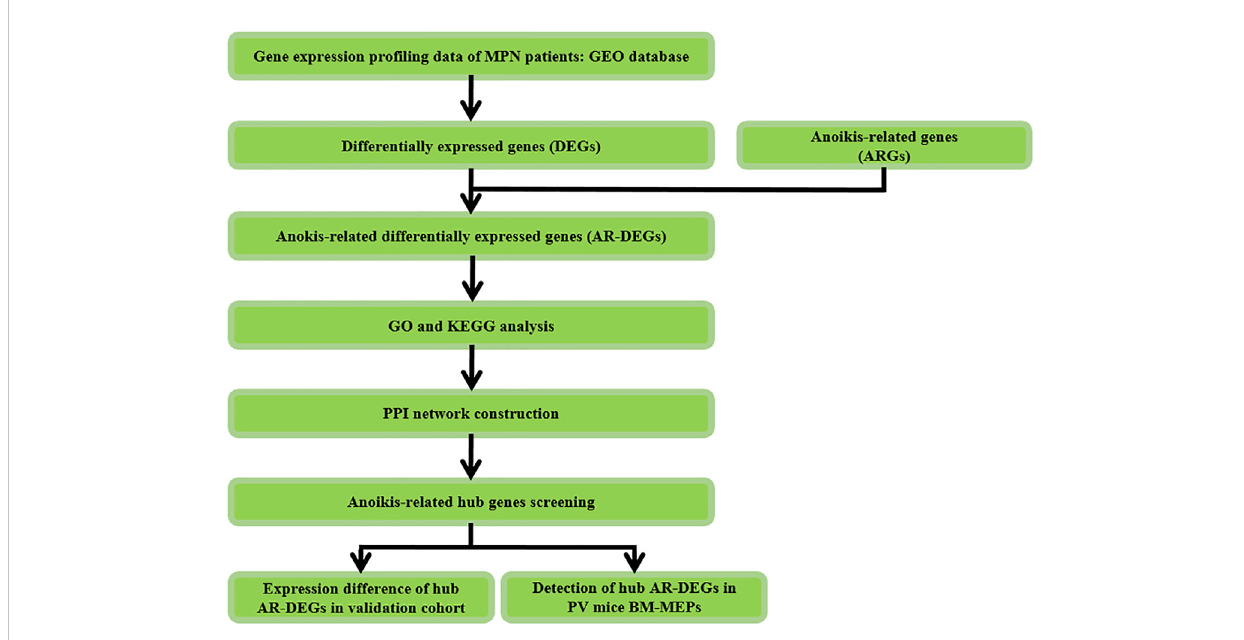
FIGURE 1 Study fl owchart. GSE, Gene Expression Omnibus Series; GO, gene ontology; KEGG, Kyoto Encyclopedia of Genes and Genomes; PV, Polycythemia Vera; BM, Bone Marrow; MEPs, megakaryocyte and erythroid